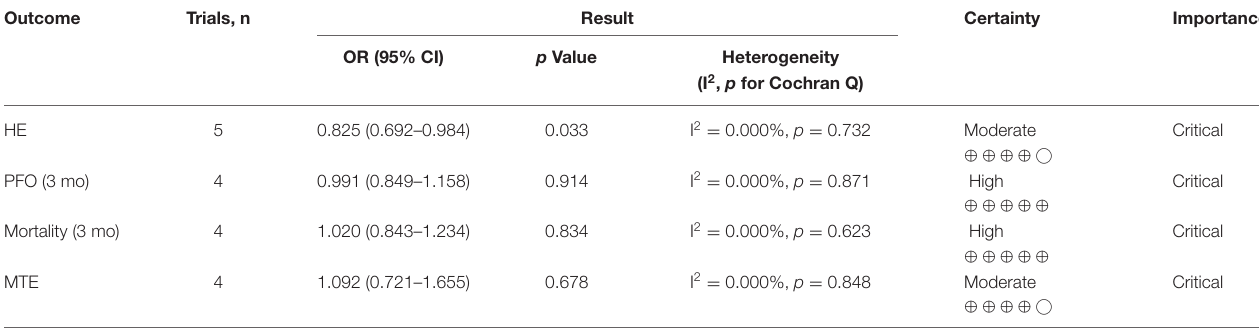
TABLE 2 | Overview of the safety and efficacy analyses on different